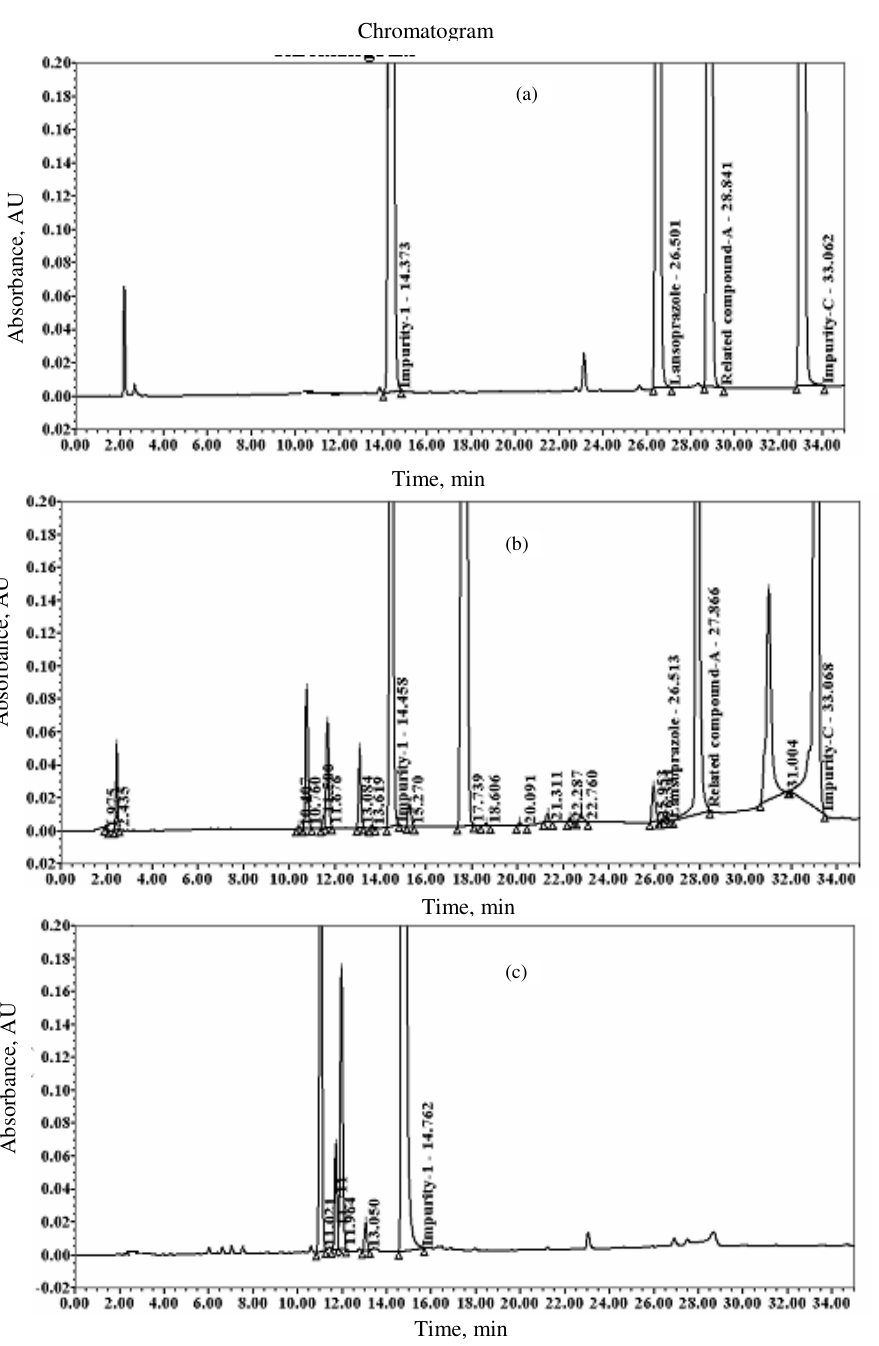
Figure 2. Typical chromatograms of lansoprazole (a) Spiked with all impurities (b) Under acid hydrolytic conditions and (c) Isolated impurity